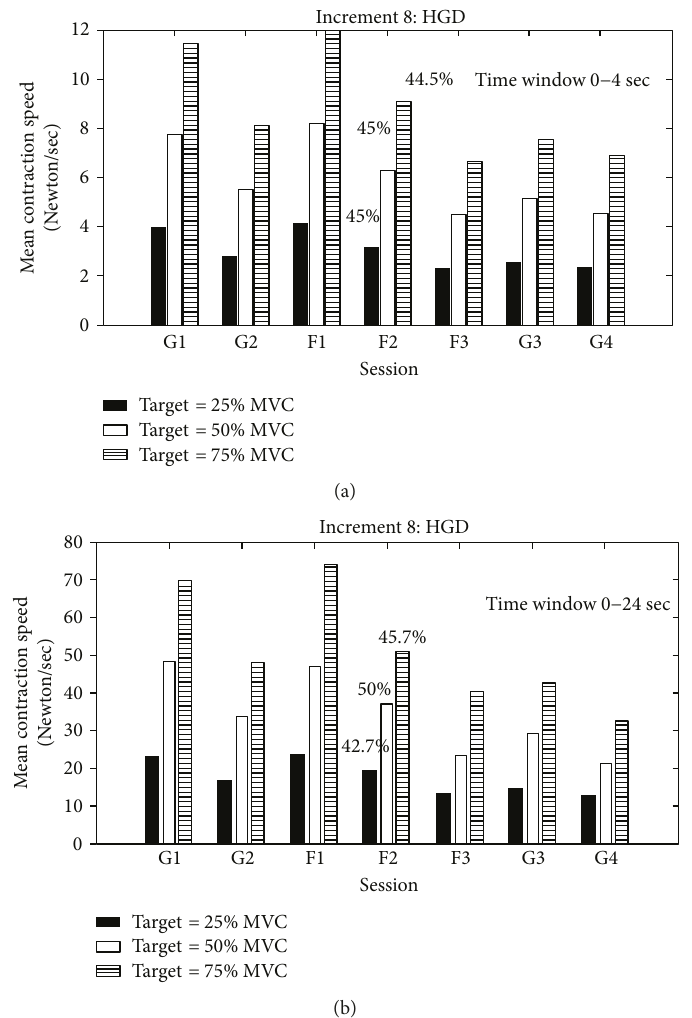
Figure 8: Contraction speed. (a) Handgrip dynamometer- (HGD-) impulsive response in the time window 0 – 4 seconds. The values of the mean contraction speed decrease, respectively, from F1 to F3 of 45% for 25% and 50% and 44.55% for 75% MVC tests. (b) Handgrip dynamometer- (HGD-) contraction speed (CS) in the time window 0 – 24 seconds. The values of the mean contraction speed decrease, respectively, from F1 to F3 of 42.7% for 25%, 50% for 50%, and 45.7% for 75% MVC tests. The timing of the di ff erent sessions is reported in Materials and